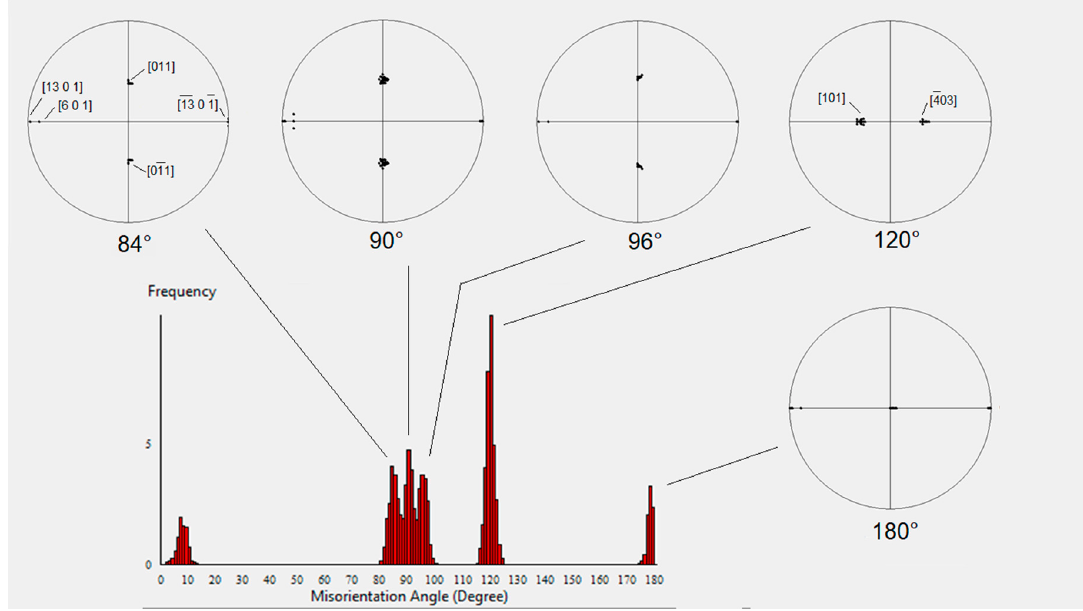
Figure 12. Simulation of the histogram of all the disorientations between all the variants generated by the OR A, AQ, C, CQ, I, and by a continuum between A and C, as represented in Figure 11. The rotations axes related to the histogram peaks are represented in a XY stereographic projection with the convention of Figure 6.